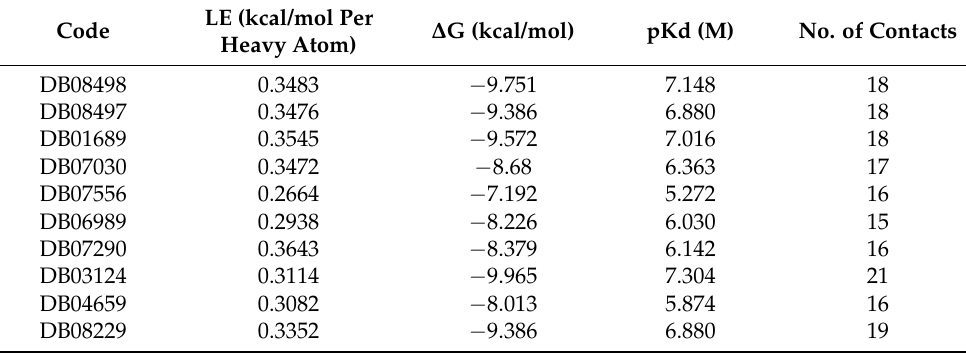
Table 6. Molecular docking simulations results for the top ranking DrugBank candidates.